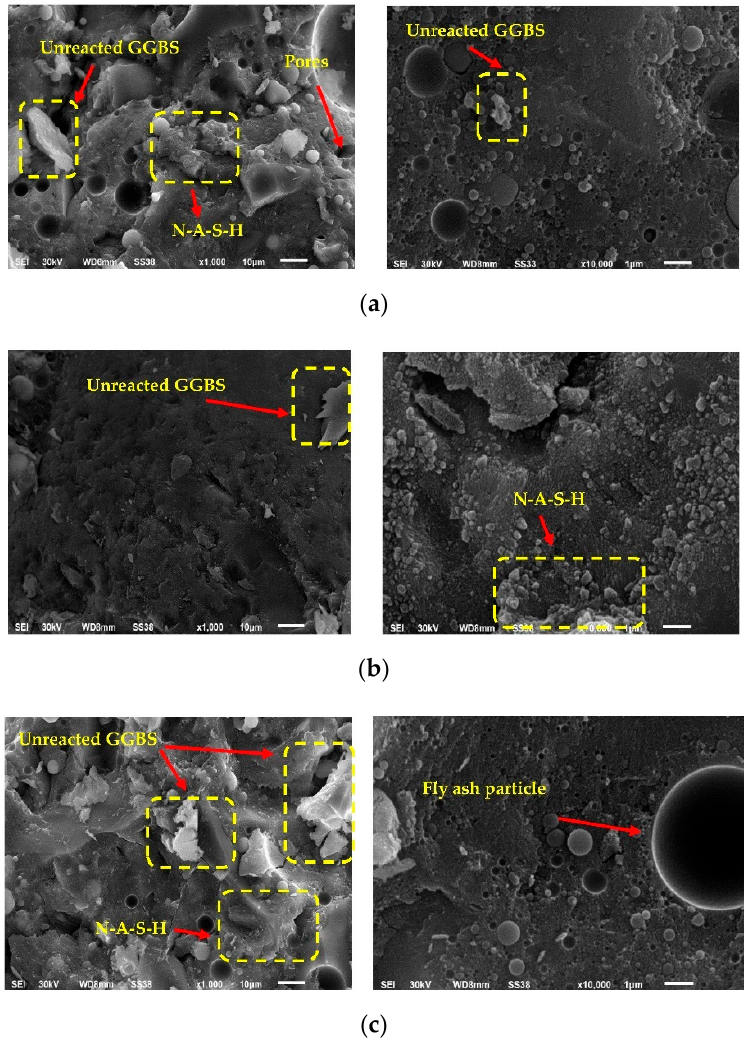
Figure 13. SEM images of UHPGC mixtures. ( a ) G1 (control mix) at 10 microns and 1-micron magnification; ( b ) G5 at 10 microns and 1-micron magnification; ( c ) G7 at 10 microns and 1-micron magnification.